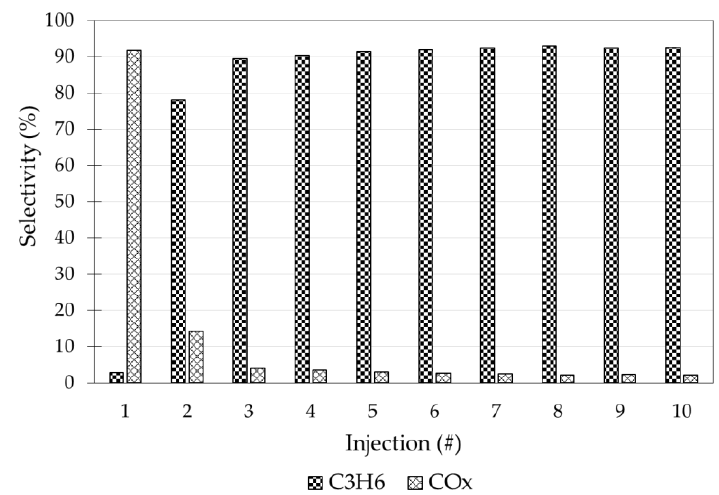
Figure 6. Propylene and CO x Selectivities during Consecutive ODH Cycles using VO x /ZrO 2 - γAl 2 O 3 (7.5 wt.% V) Catalysts (Operating conditions: T = 550 °C, reaction time = 20 s, C 3 H 8 injected = 10 mL, catalyst loaded = 0.76 g). Standard deviations for repeats: 1.5%. Note: Reported selectivities are based